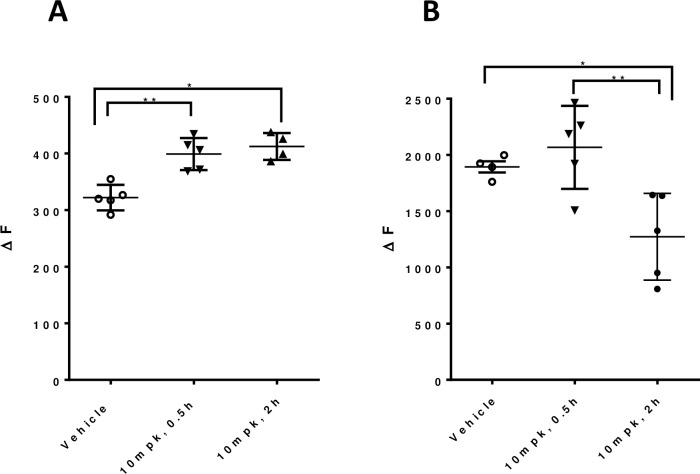
In vivo mTOR inhibition resulted in a measurable stimulation of autophagy.6 month mice were treated one time with a mTOR inhibitor and sacrificed 0.5 or 2 hours afterwards. mTOR inhibition increased LC3B-II (A) and reduced p62 (B) levels in the mouse liver, as measured by TR-FRET and expressed as the fluorescence ration (665/615 nm) ΔF; N = 5; one-way ANOVA, p<0.01; Tukey’s multiple comparison test, *p<0.05, **p≤0.01.